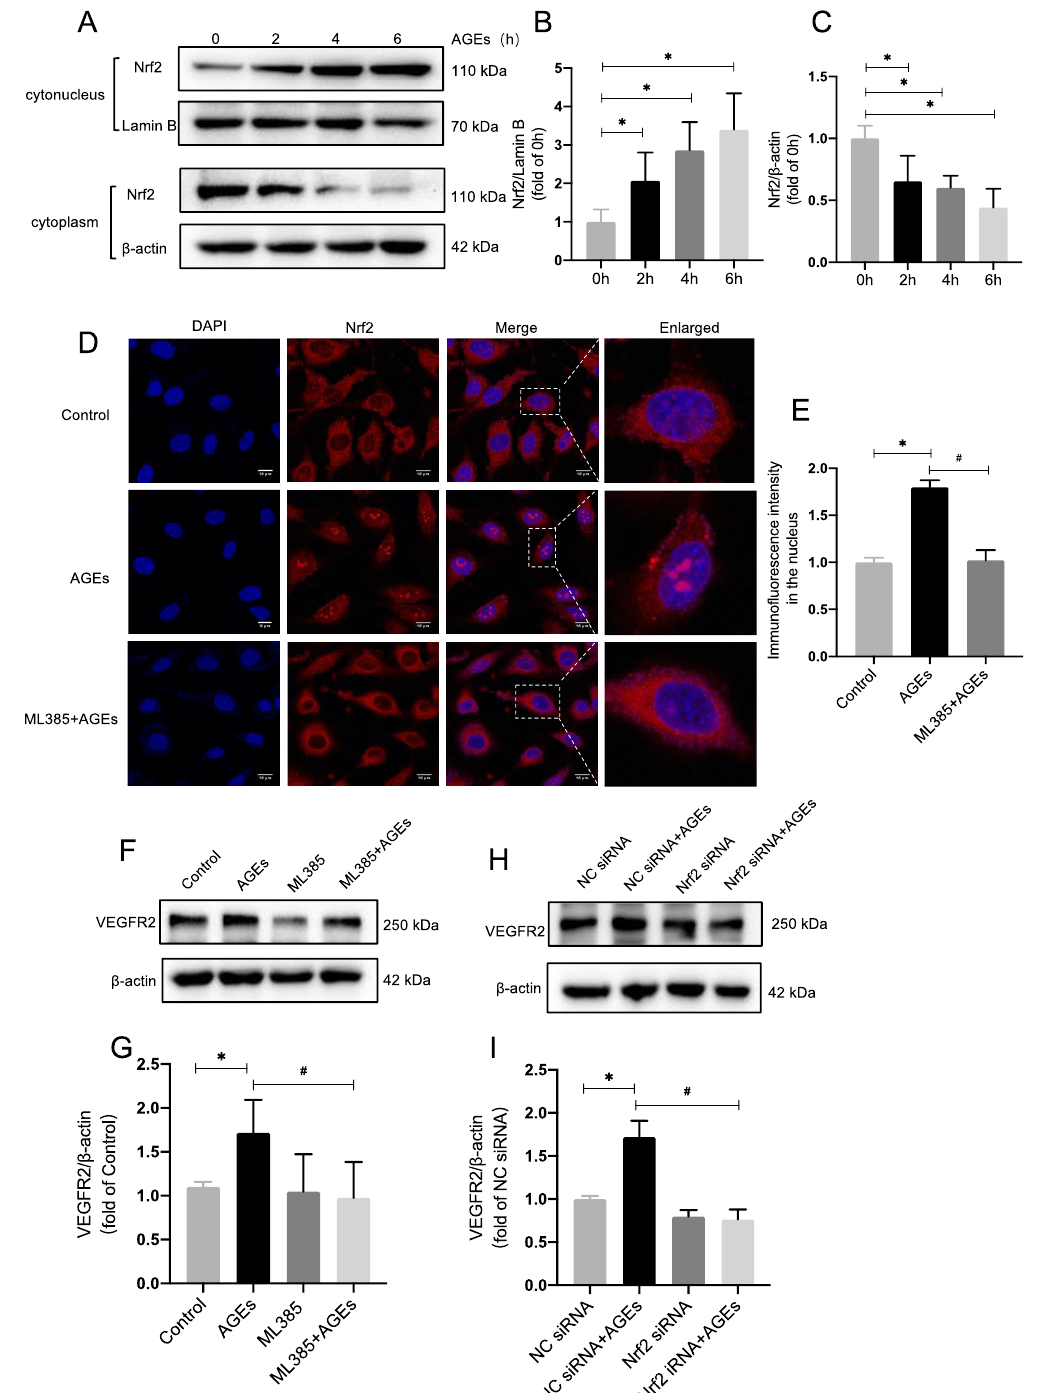
Figure 1. AGEs upregulate VEGFR2 expression by inducing Nrf2 translocation into the nucleus. ( A – C ) 100 µ g/mL AGEs were applied to HUVECs to stimulate them for 0, 2, 4, and 6 h, n = 5, * p < 0.05 vs. 0 h. ( D , E ) Immunofluorescence staining, Nrf2 (red); nucleus (blue), and HUVECs were stimulated with AGEs for 6 h after being pretreated with ML385 (5 mM) for 1 h, n = 4, Scale bar: 10 µ m. ( F , G ) AGEs stimulation and pretreatment with the inhibitor ML385, VEGFR2 expression in HUVECs was detected. n = 8. * p < 0.05 vs. control, # p < 0.05 vs. AGEs. ( H , I ) Pre-transfection of Nrf2 siRNA and NC siRNA, detect the expression of VEGFR2. n = 7, * p < 0.05 vs. NC siRNA, # p < 0.05 vs. NC siRNA + AGEs. * and # indicate significance between the indicated